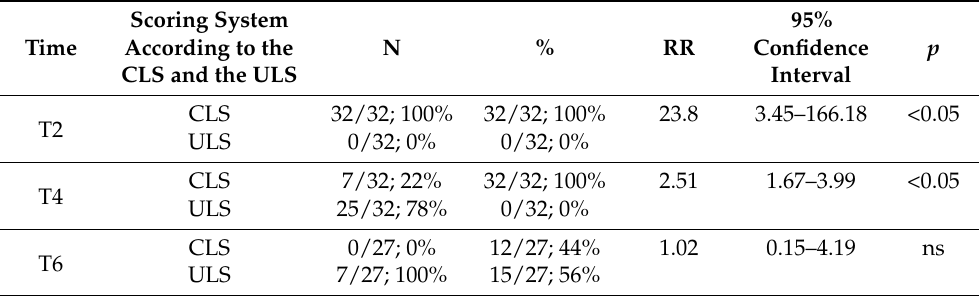
Table 4. Relative Risk (RR) of the Ultrasonographic Lesion Score (ULS) as compared to the Clinical Lameness Score (CLS). The CLS is used as a control scoring system. N: number of patients. Scoring System Time According to